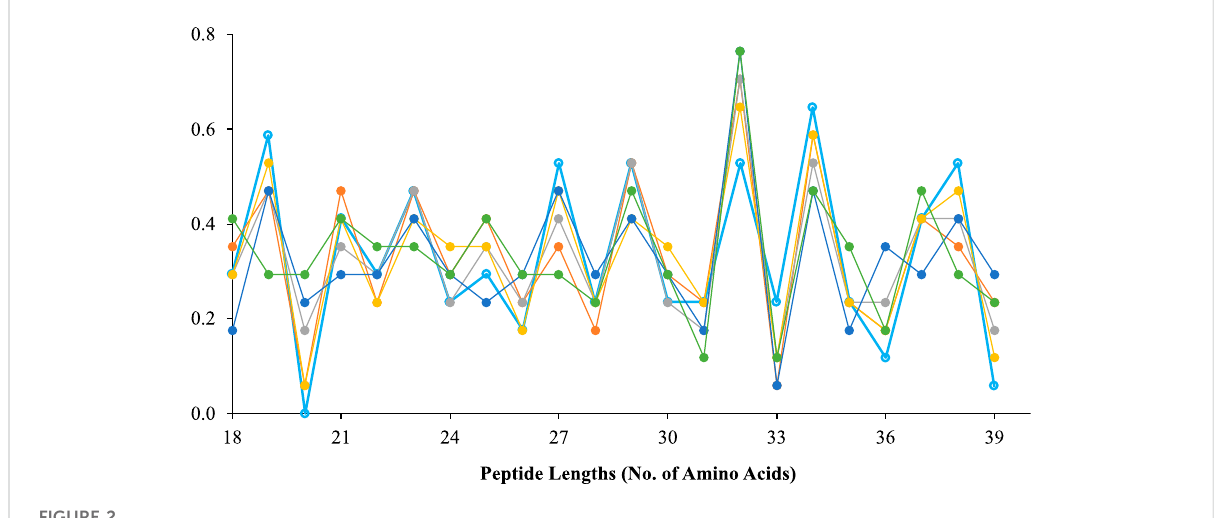
FIGURE 2 Schematic illustration of the sequence diagram of CTDC that showed the time sequence feature of the data type.